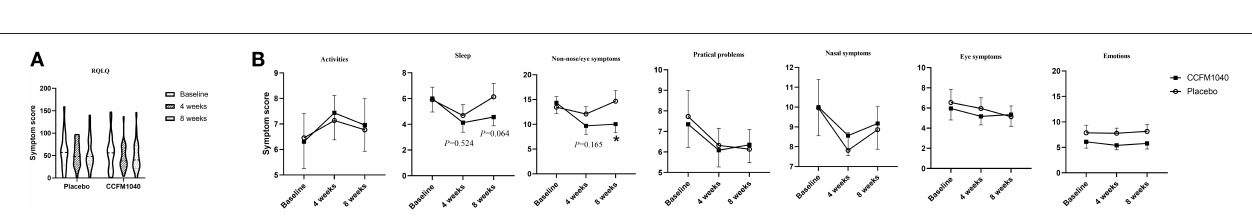
FIGURE 2 | Clinical symptoms in CCFM1040 and placebo groups during the study period. Results in TSS of AR (A) , ACT of asthma (B) , and subgroups symptom scores of AR (C) . Data are expressed as mean (SEM). The differences between the groups were compared using the t -test, and the P -values are at a 5% level vs. placebo. AR, allergic rhinitis; TSS, total symptom score; ACT, asthma control test.